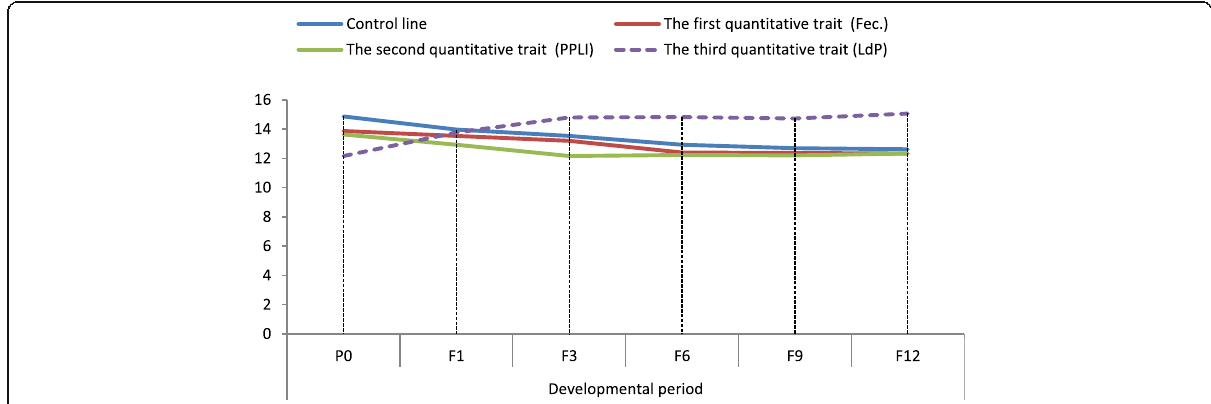
Fig. 3 Changes in the developmental period according to the change of genetic improved lines